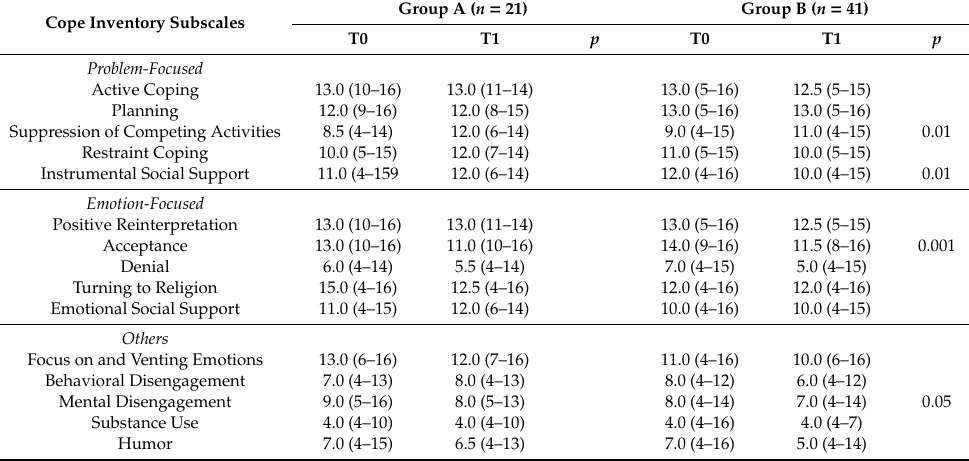
Table 3. Median scores and ranges (min–max) of Coping Orientation to Problems Experienced (COPE) Inventory subscales in CHC patients with (Group A) and without (Group B) a current or lifetime psychiatric history, before (T0) and 12 weeks after completing treatment with direct-acting antiviral (DAA) agents